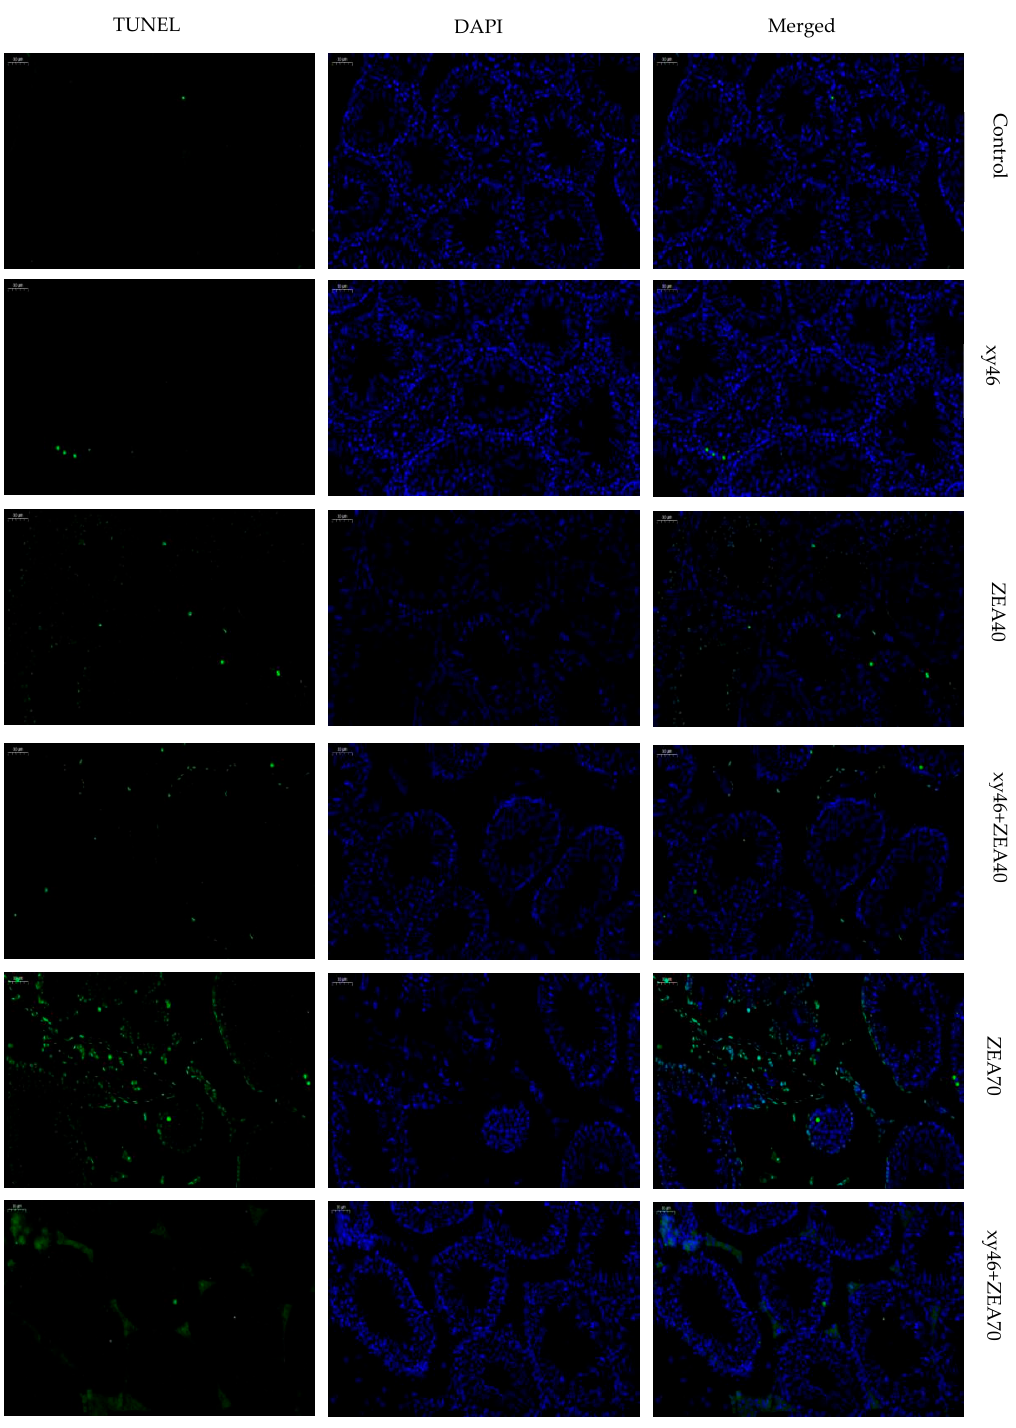
Figure 9. Results of TUNEL staining of mouse testis tissue. Green fluorescence indicates TUNEL-positive cells. DAPI was used for nuclear staining in the microscopic fields. Magnification is 200×.